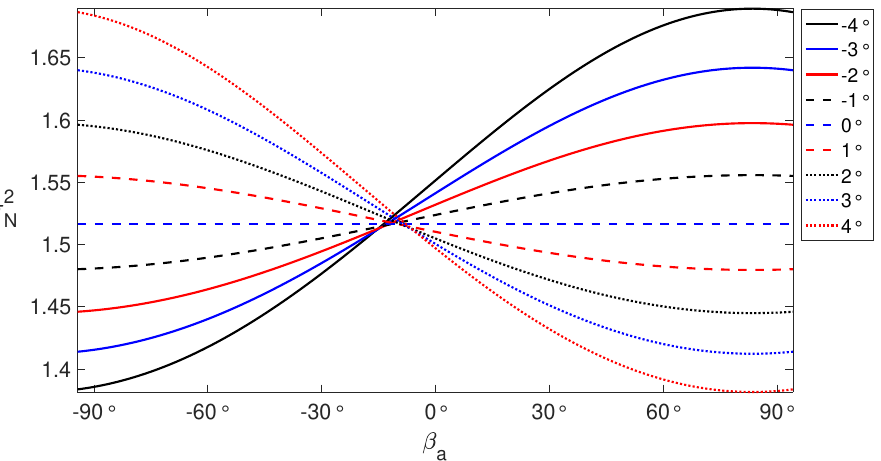
Figure 3. σ 2 values in response to the variation of β a [ − 90 ◦ , 90 ◦ ] and γ s [ − 4 ◦ , 4 ◦ ]. The Sentinel-1 N satellite look angle θ = 35.7 ◦ and heading α h = 349.8 ◦ are